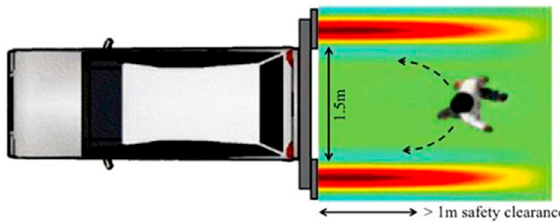
Figure 3. Representation of the guiding system [33].